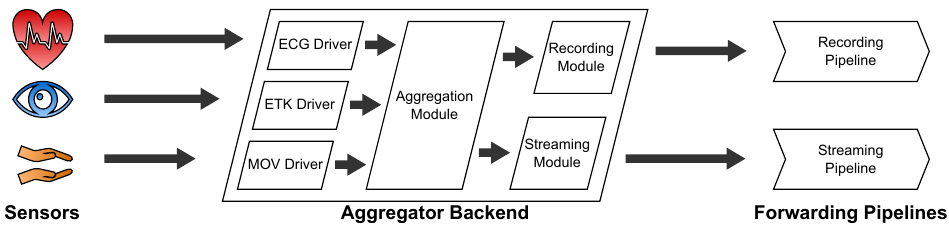
Figure 4. Architecture of the Aggregator